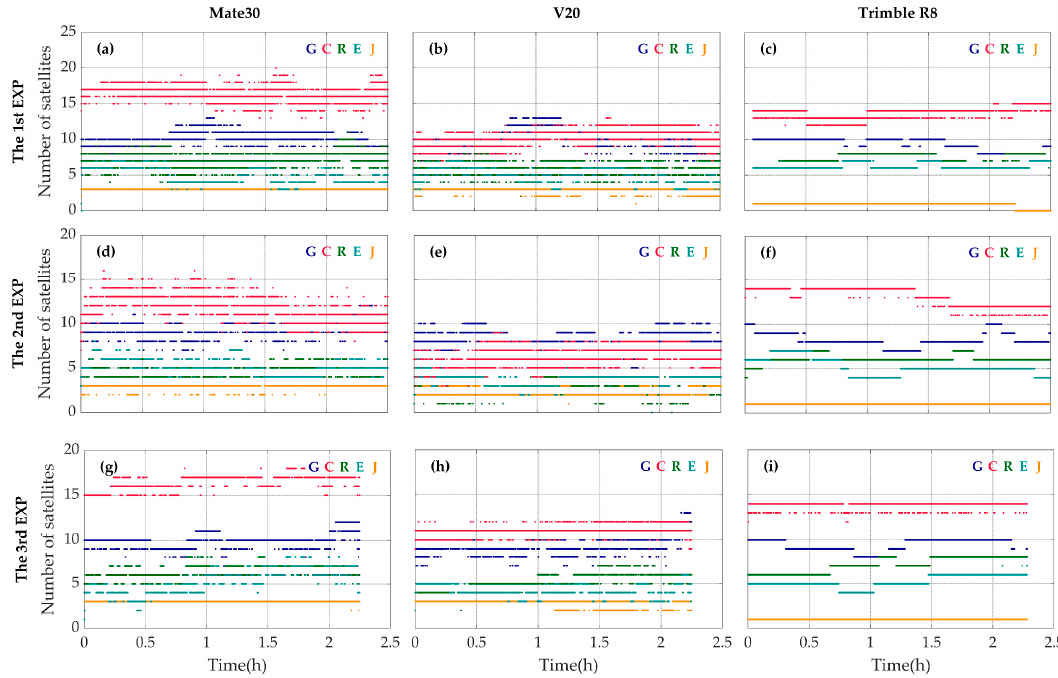
Figure 4. The numbers of GPS (blue), BDS (red), GLONASS (green), Galileo (cyan) and QZSS (orange) satellites with the signal of the first frequency tracked by the Mate30 smartphone ( a , d , g ), the V20 smartphone ( b , e , h ) and the geodetic receiver Trimble R8 ( c , f , i ) during the first ( a – c ), the second ( d – f ) and the third ( g – i ) observing